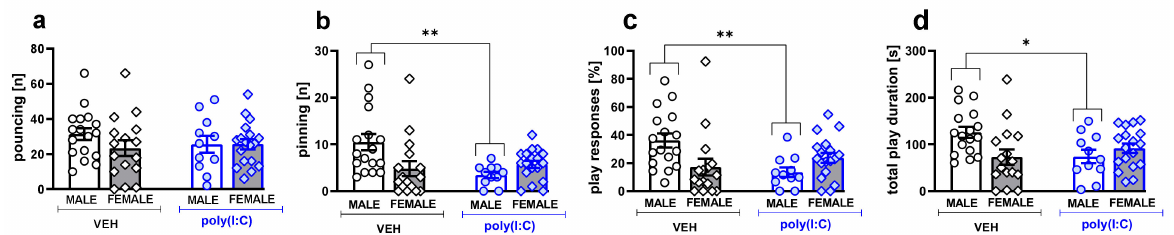
Figure 1. Poly (I:C) exposure reduced social play behavior in males. Data are presented as a mean ± SEM of the number of pouncing ( a ) and pinning episodes ( b ), the percentage of play responsiveness ( c ), and total play duration ( d ). Symbols: ** p < 0.01, * p < 0.05, a significant difference between vehicle- and poly(I:C)-exposed animals in a given sex group (Mann–Whitney U test ( b , c ) and Student’s t -test ( d